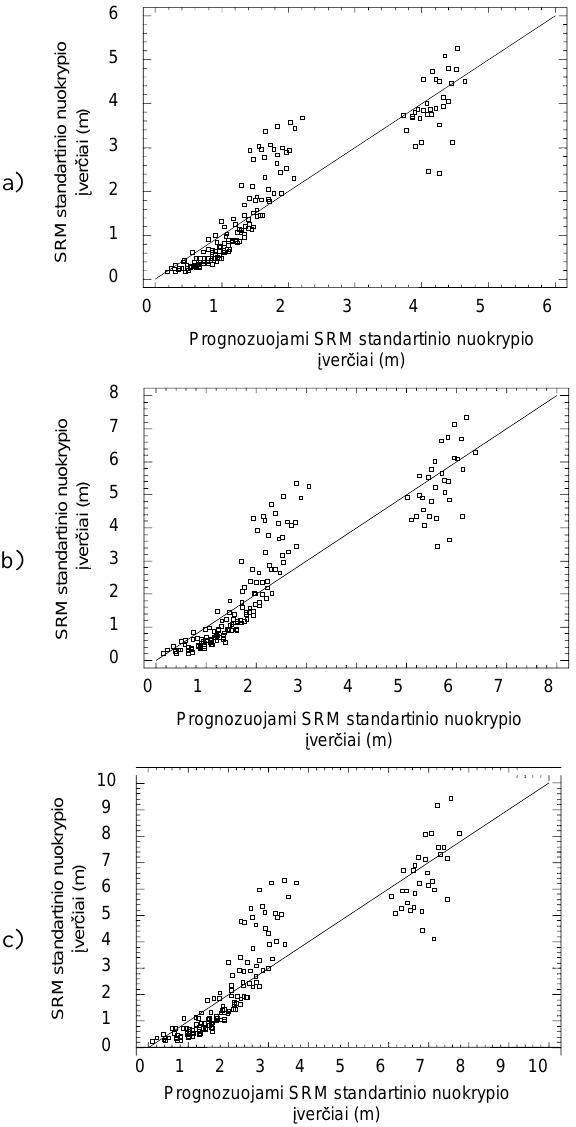
atstumus tarp aukš č i ų tašk ų ir morfometrinius rodiklius: a) krigingo metodas; b) splaino metodas; c) svorinis metodas Fig 2. Dispersion of regression results, evaluating by cell, distance between the high points and morphometric index: a) kriging method; b) spline method; c) IDW method tiesin ę priklausomyb ę nuo modeliavimo parametr ų ir reljefo morfometrini ų rodikli ų